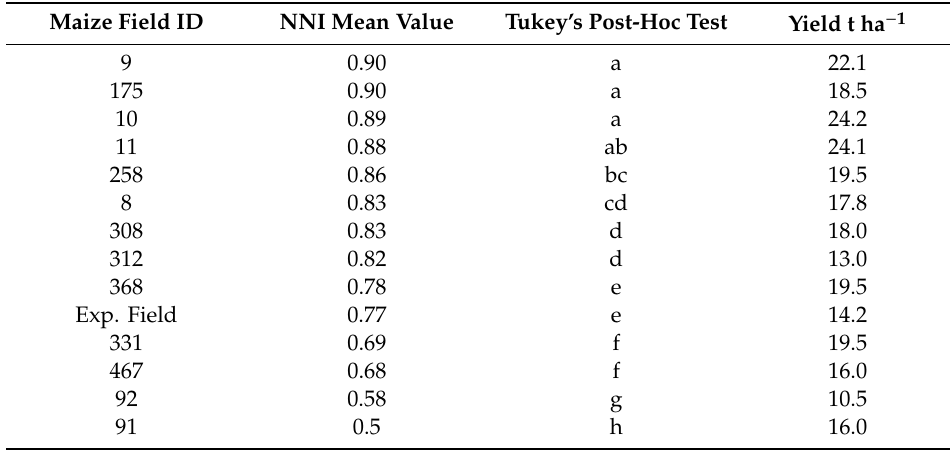
Table 9. Yield and NNI mean values (directly derived using S2 image of 08 July) of each maize field of the farm analyzed using the ANOVA method (di ff erent letters are significantly di ff erent at p < 0.05). Maize Field